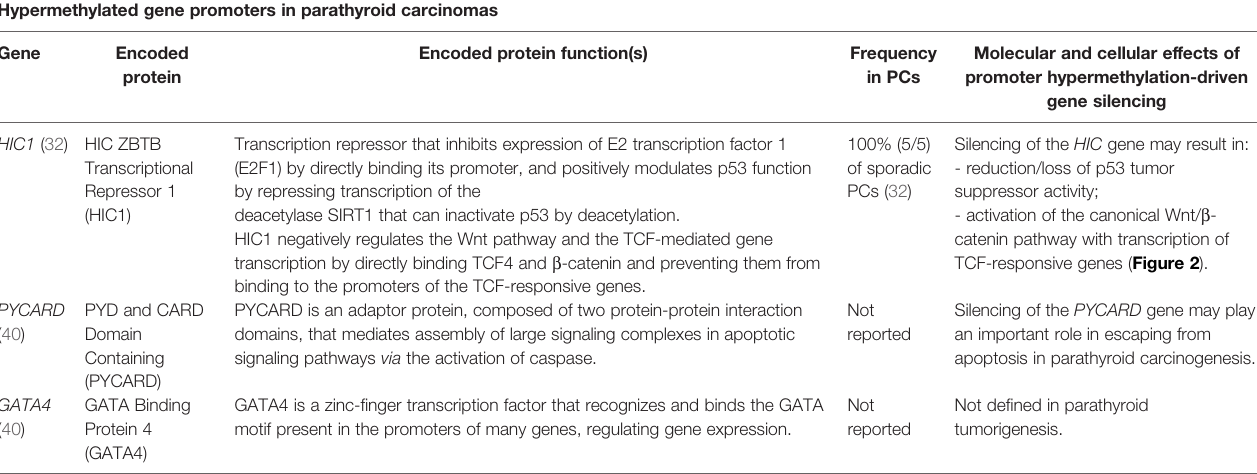
TABLE 2 | Hypermethylated gene promoters in parathyroid tumors compared to normal parathyroid tissue. Hypermethylated gene promoters in parathyroid carcinomas Encoded Encoded protein function(s) Frequency protein